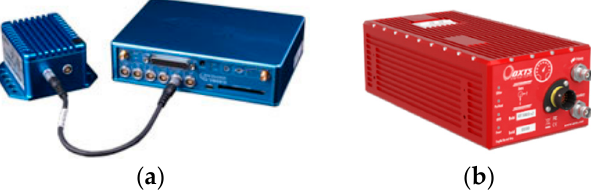
Figure 1. Instrumentation equipment: ( a ) Racelogic Inertial Measurement Unit (IMU) (RLVBIMU04) and ( b ) Oxford Technical Solutions RT3000.